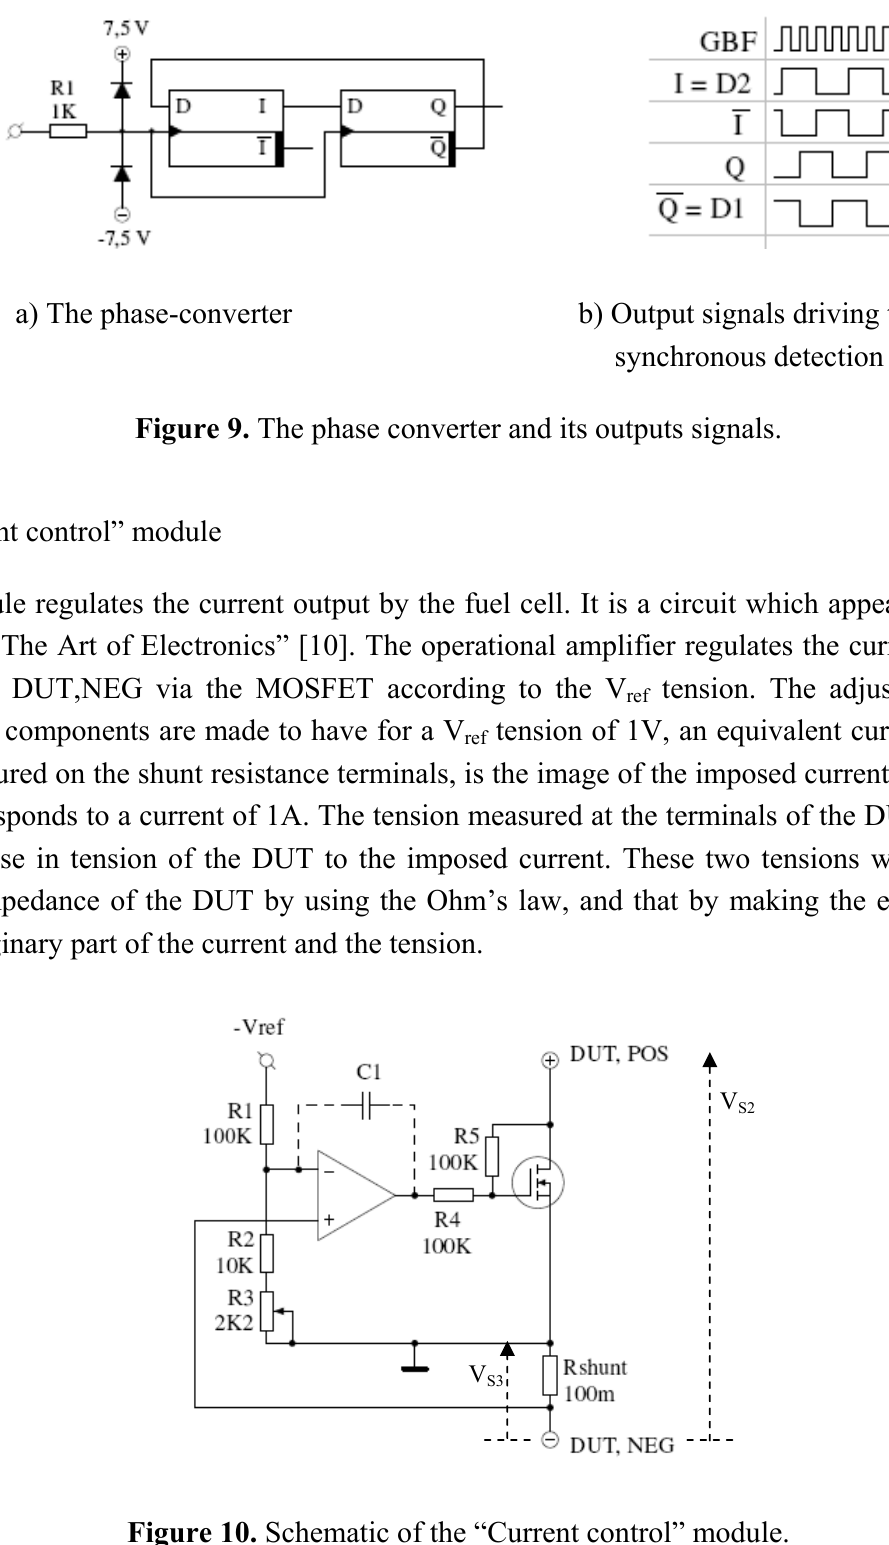
Figure 10. Schematic of the “Current control”